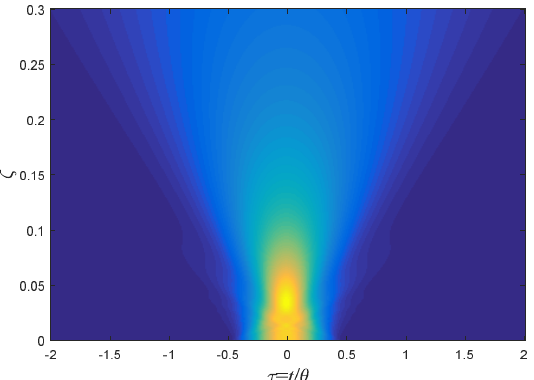
Figure 12. Similar to Figure 10, but for the bounded cosine pulse (Equation (39)) and for the final  z . distance of 3.0/ 2 2